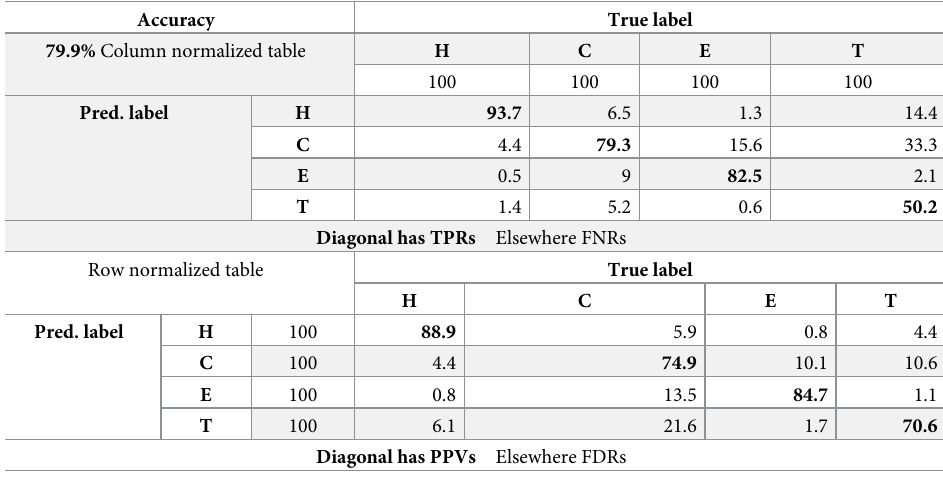
Table 11. 4-label practical alphabet: H , C , E , and T : (1) true positive rates (recalls) and false negative rates and (2) positive predictive values (precisions) and false discovery rates of SecNet